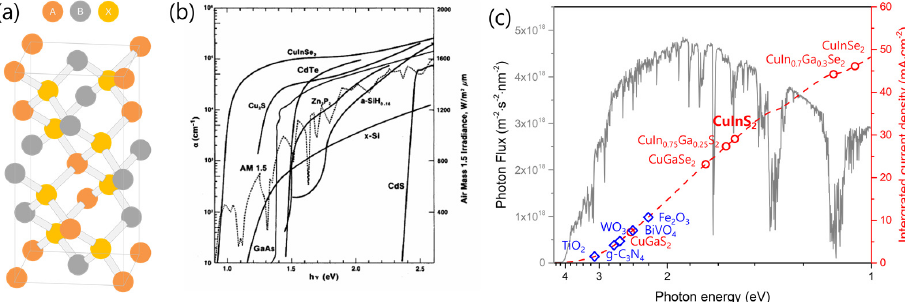
Figure 3. ( a ) Chalcopyrite unit-cell. ( b ) Absorption coefficient of various semiconductor materials [9]. ( c ) Bandgap of chalcopyrite semiconductors and other semiconductor materials. Integrated pho-